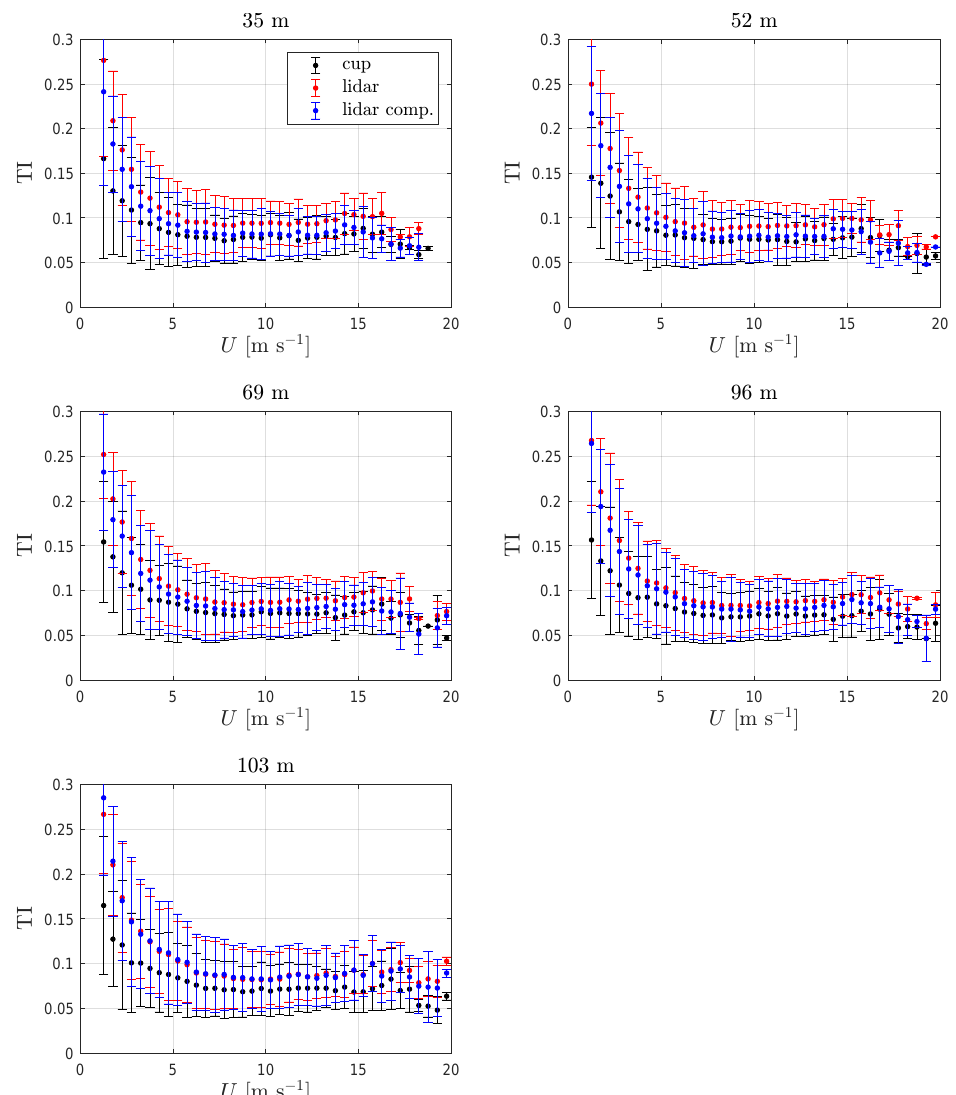
Figure 11. Turbulence intensity (TI) over a number of horizontal velocity bins computed from the cup anemometer, the ZX lidar, and the ZX lidar turbulence compensated measurements for each of the observed vertical levels. Error bars denote ± one standard